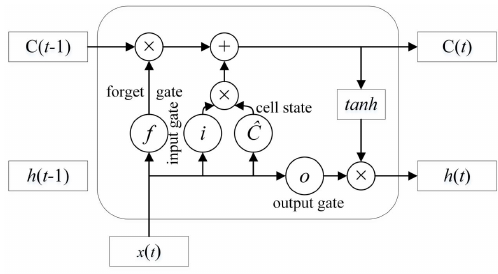
Figure 2. The architecture of the Long Short-Term Memory (LSTM) neural network model.